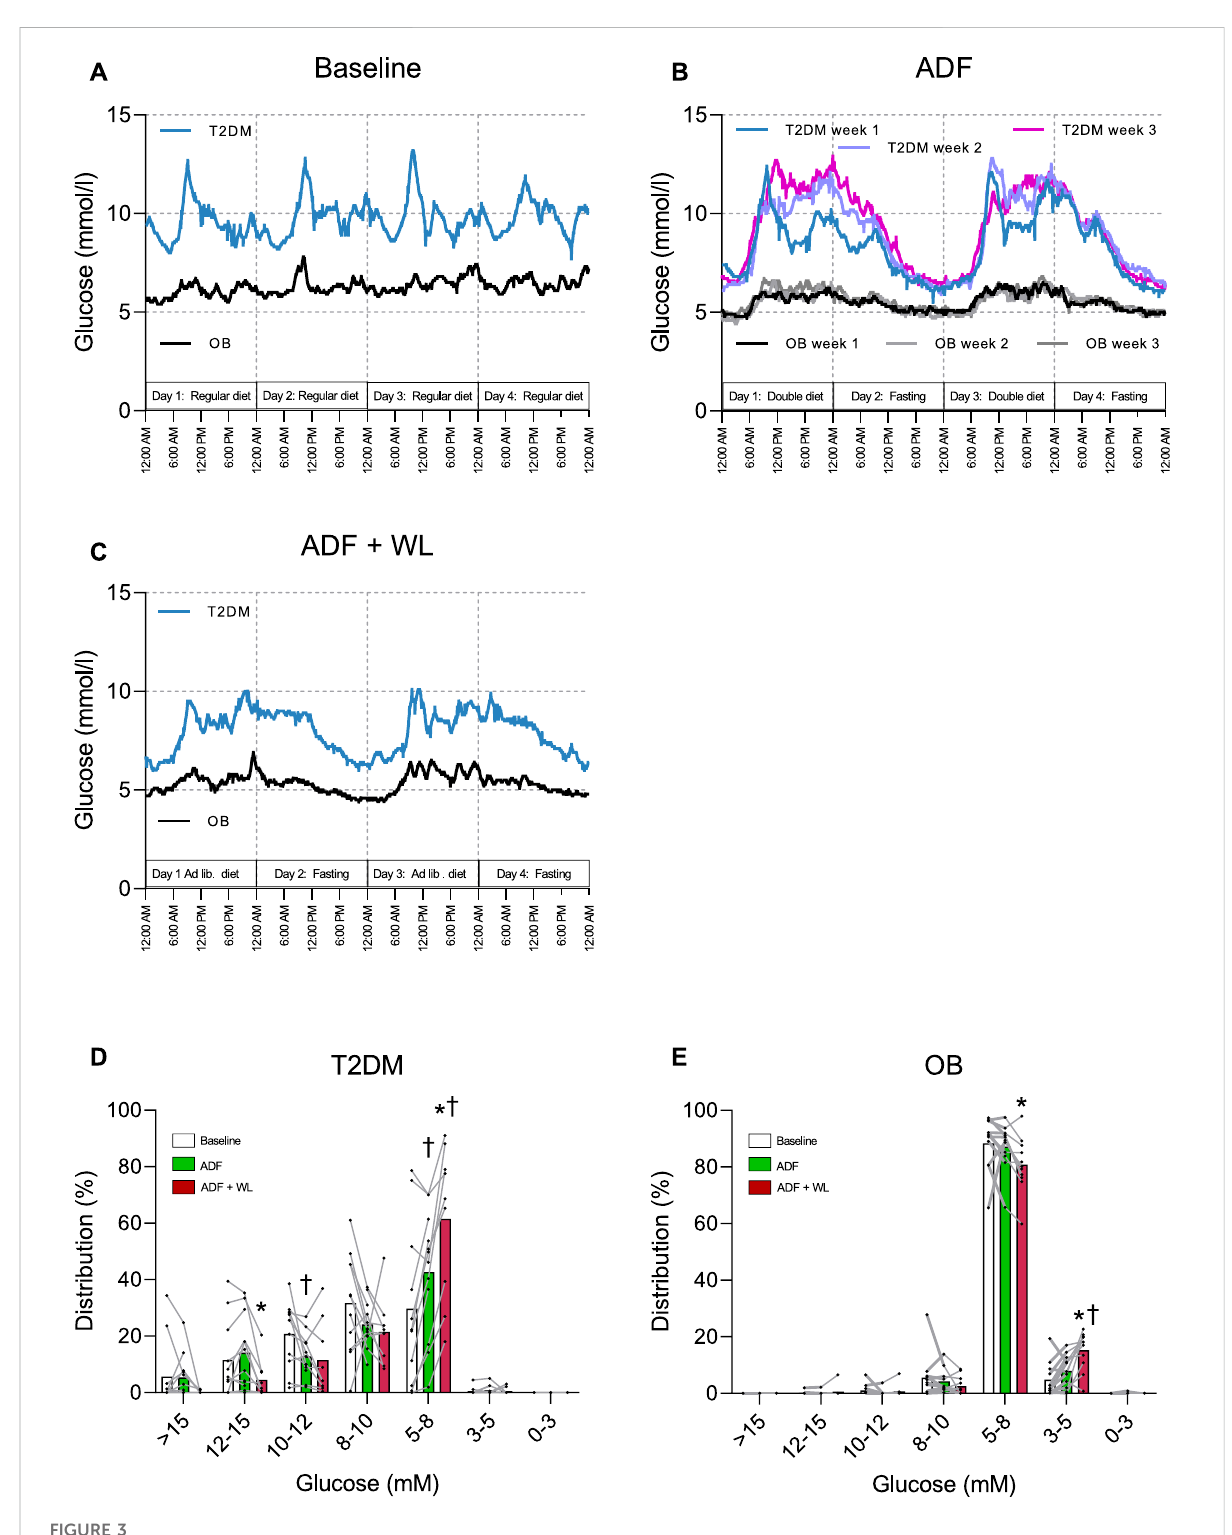
FIGURE 3 Continuousglucosemonitoring (CGM) traces inpatientswith obesity (OB)andtype2 diabetes(T2DM).Data areshown asmeanvalues. (A) four consecutive days during 1 week between baseline tests; (B) four consecutive days during week 1, 2 and 3 of alternate day fasting (ADF); (C) four consecutivedaysduring1 weekwithallowedweight-loss(ADF+WL).Thedistributionoftime(%)(mean±SD)spentinrangesofglycemiaareshown in column graphs for patients with T2DM (D) and OB (E) during baseline, ADF and ADF + WL. † denotes different from Baseline, * denotes different from